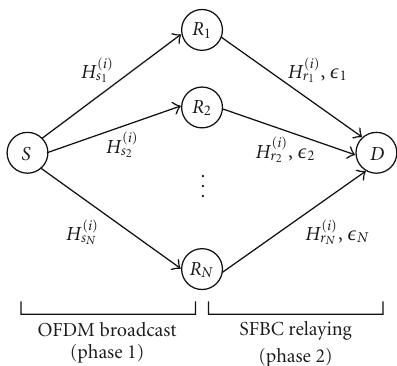
Figure 1: A cooperative SFBC-OFDM network consisting of one source, one destination, and N